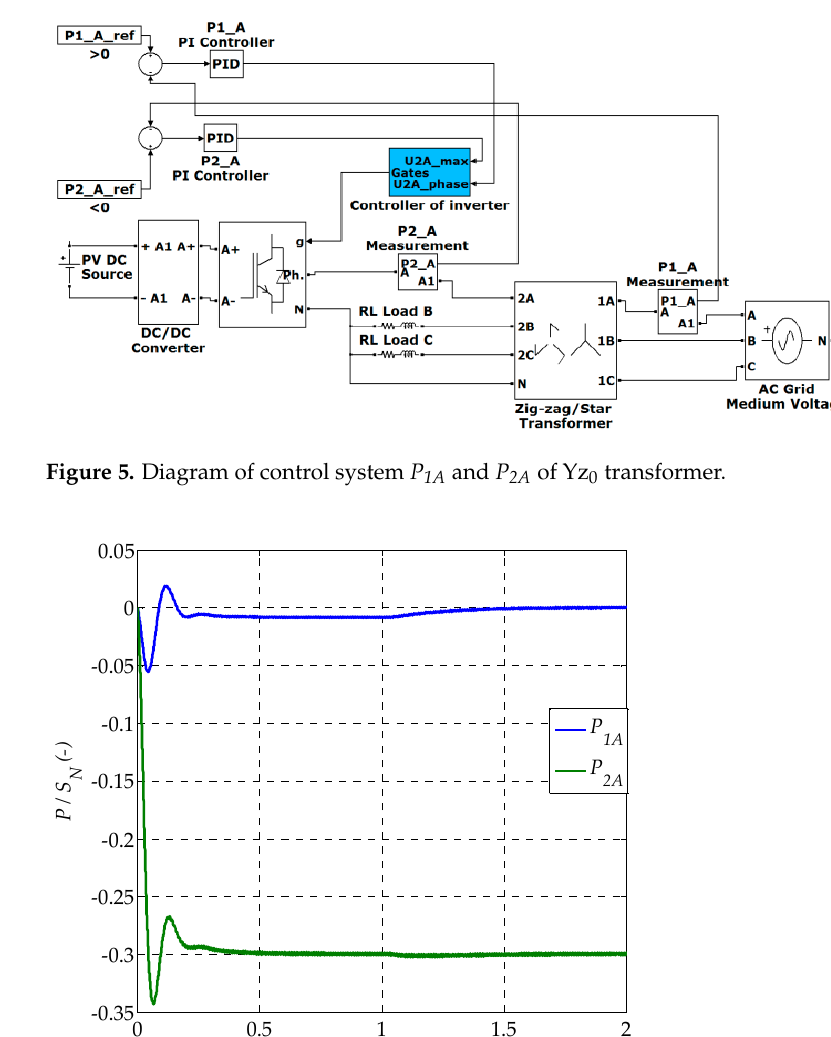
Figure 5. Diagram of control system P 1A and P 2A of Yz 0 transformer.